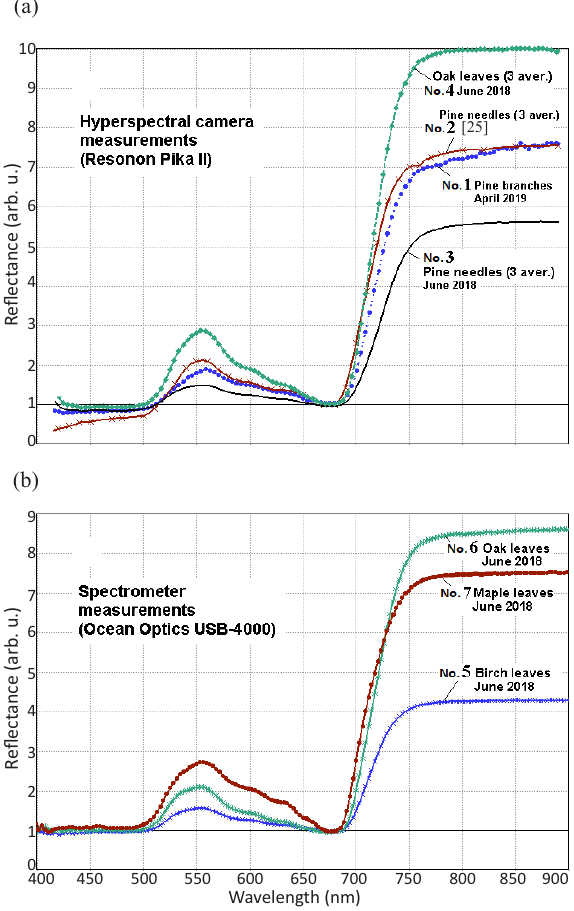
Fig. 5. Collection of seven sets of actual green vegetation reflectance spectra measured by two devices: (a) Resonon hyperspectral camera and (b) Ocean Optics compact spec trometer. The curves are presented in normalized units with respect to the common minimum near the wavelength of 670 nm. The HS camera outdoor calibration was done by standard methodology by using a white test object. The spectrometer results were obtained in laboratory as the ratio of the measured object reflection and the light source (halogen lamp) intensity at measured